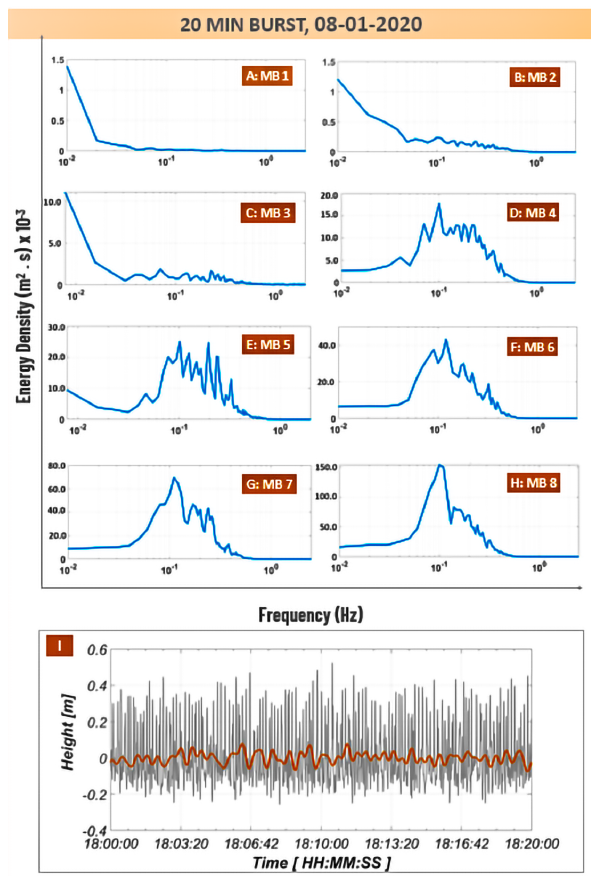
Figure 10. Averaged wave energy density spectra of simultane- ously obtained wave data during full inundation of the cross-shore transect (MB) at Chateau Margot, each for the period 6–11 January 2020. Sensor positions, MB1–MB8 (A–H), refer to the positions indicated in Fig. 2. The sensors located on the mudflat are MB 4, MB 5, MB 6, MB 7 and MB 8 and extend from the mangrove edge to 1620m offshore. In the mangrove, sensors MB 1, MB 2 and MB 3 , 1 are placed at points 1 and 3 of the forest width. (I) Swell and in- 4 2 4 fragravity wave bands along the coastline at position MB